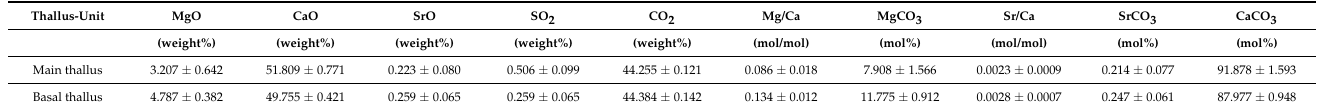
Table 2. Summarized quantitative EMP-spot measurements of the basal thallus (n = 5) and the main thallus (n = 55).